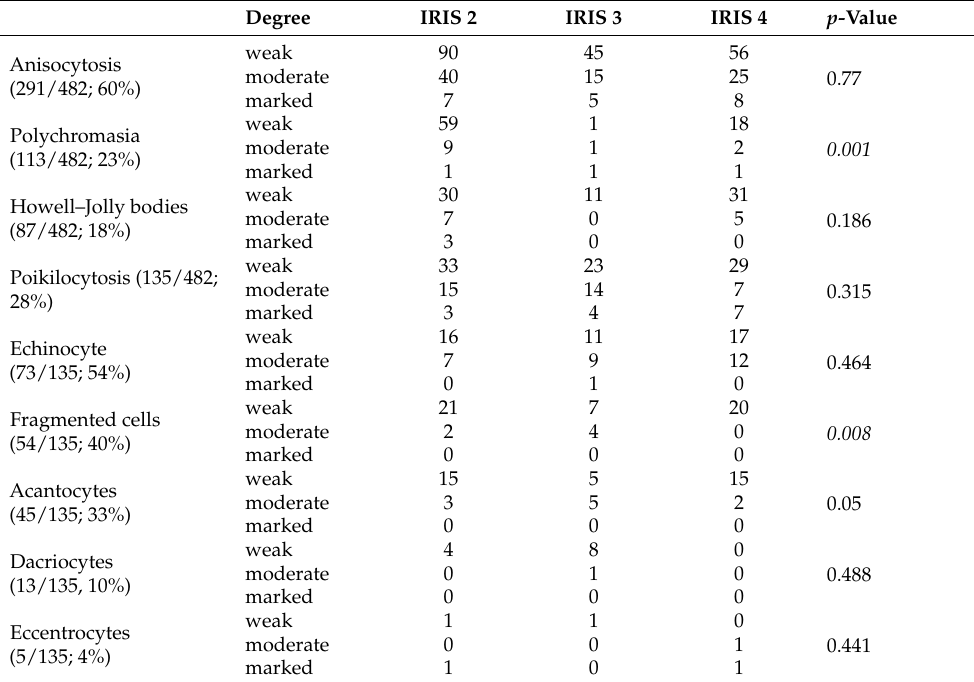
Figure 3. Spearman’s correlation analysis between HGB and serum creatinine and urea. Statistically significant, negative linear correlation ( p < 0.0001; r − 0.3286) between HGN (g/dL) and serum creatinine (mg/dL), and statistically significant negative linear correlation ( p < 0.0001; r − 0.2194) between HGB (g/dL) and serum urea (mg/dL) in the totality of anemic CKD dogs ( n = 302). Morphological abnormalities of the erythrogram are reported in Table 4. Table 4. Chi squared comparison of morphological abnormalities of the erythrogram in dogs at different CKD IRIS